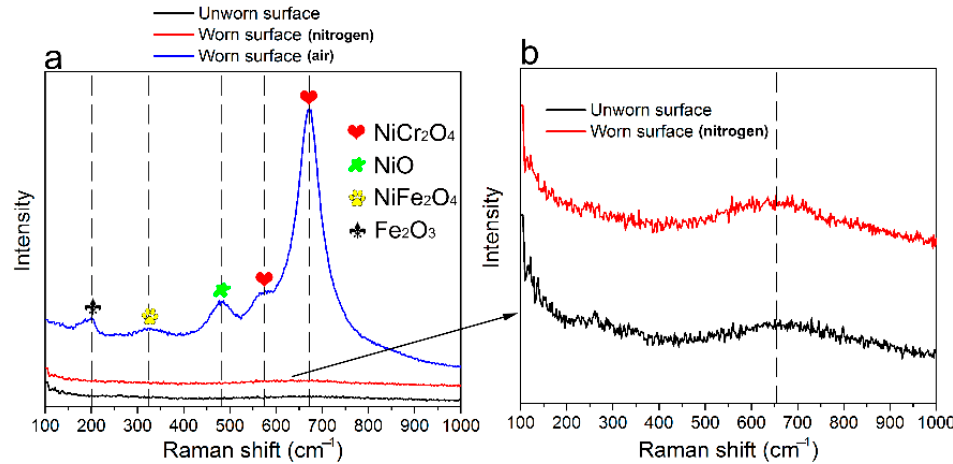
Figure 8. ( a ) Raman spectroscopy for the worn scars of alloy 690 during fretting wear at the displacement amplitude of 60 μ m in air and nitrogen. ( b ) The magnified image of the curves from ( a ).